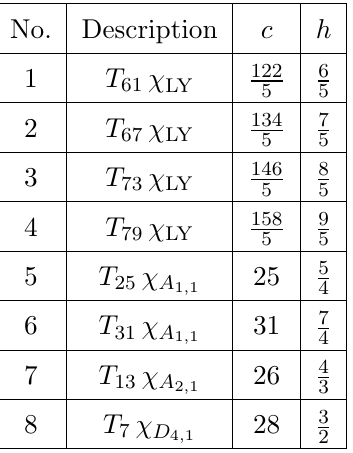
Table 5 . Admissible Hecke images with ‘ =